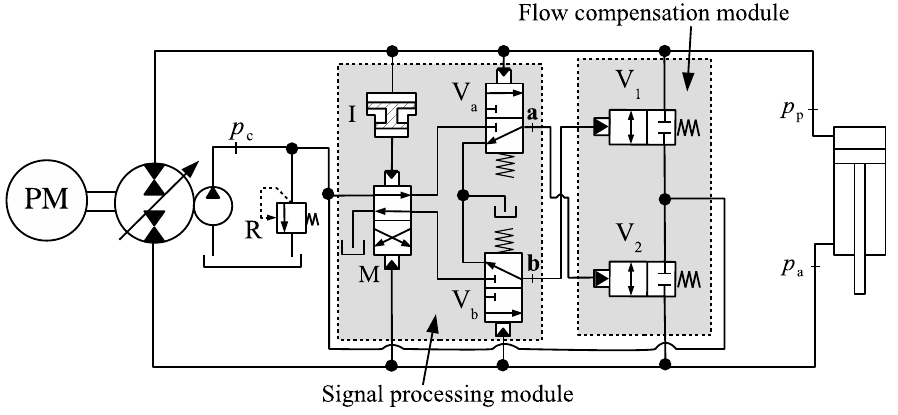
Figure 8. Circuit with signal processing and flow compensation modules [15].